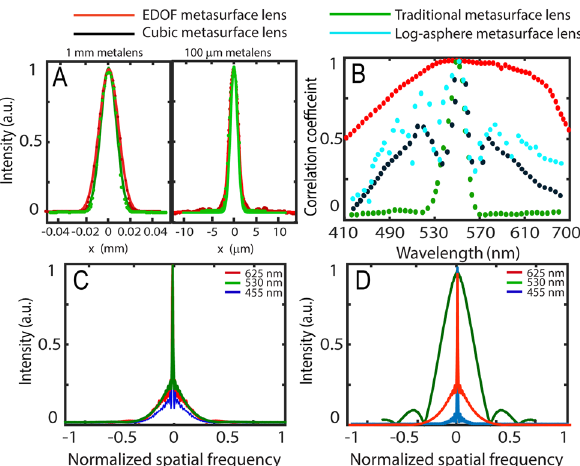
Figure 2: Characterization of the metasurfaces: (A) PSF of the traditional and EDOF metalenses for 1 mm and 100 μ m focal length. (B) Correlation coef fi cient plots for four different metalenses as a functionofwavelength.(CandD)Thecorresponding x – y planecross sections of the experimental MTFs for our EDOF metalens (C) and traditional metalens (D) are displayed with red lines from its PSF measured under red light, green lines under green light, and blue lines under blue light. The MTF plots have a spatial frequency normalized to 560